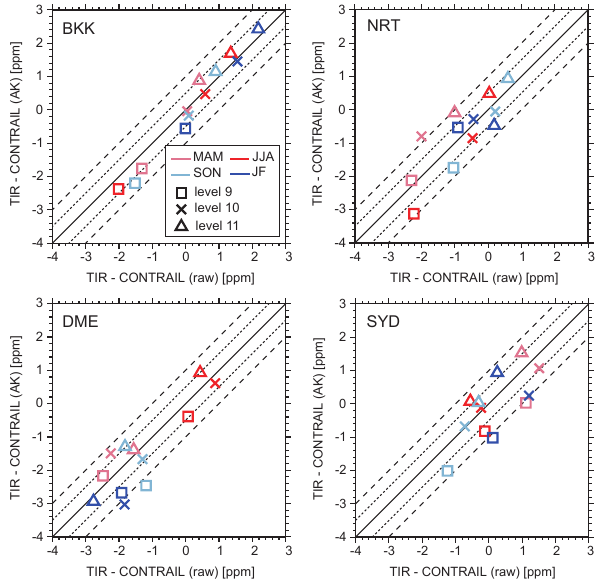
Figure 4. Scatterplots of GOSAT/TANSO-FTS TIR and CON- TRAIL (raw) CO 2 differences and GOSAT/TANSO-FTS TIR and CONTRAIL (AK) CO 2 differences in layers 9, 10, and 11 for each season.